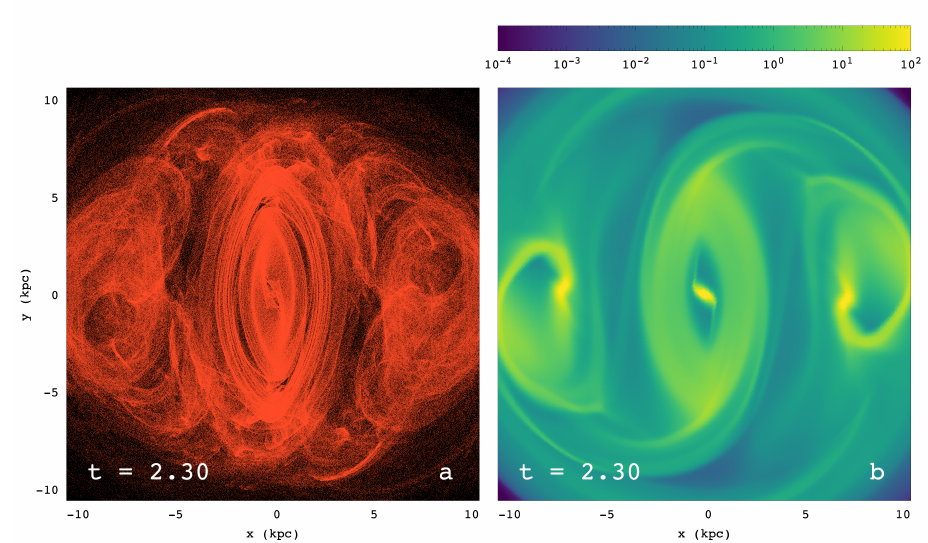
Figure 17. A model in which the amplitude of the bar reaches only 50% of that of the main model. ( a ) The stellar response. ( b ) The gaseous RAMSES model. The disks of the models are populated initially homogenously. The model has features pointing to a more regular orbital